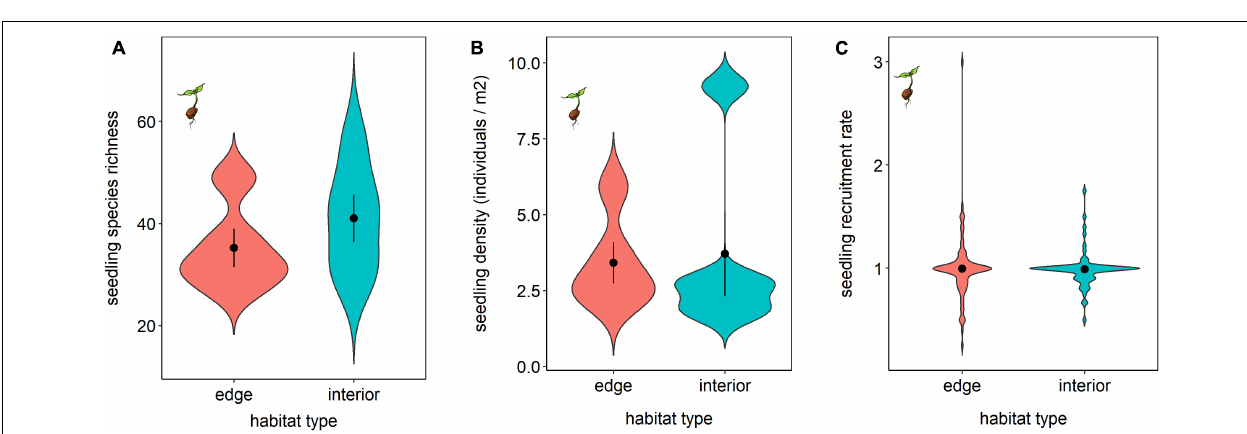
FIGURE 2 | Rates of animal-mediated seed dispersal (A) and size distribution of the animal-dispersed seeds (B) in forest edge and interior habitats.